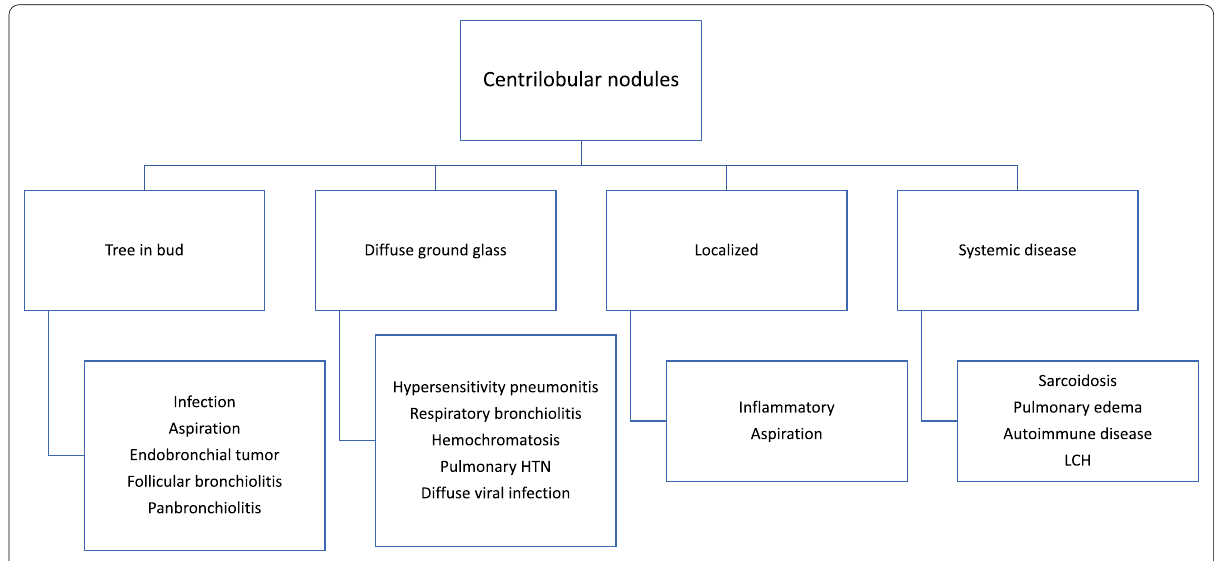
Fig. 10 HRCT simplified algorithmic approach for diagnosis of centri-lobular pulmonary